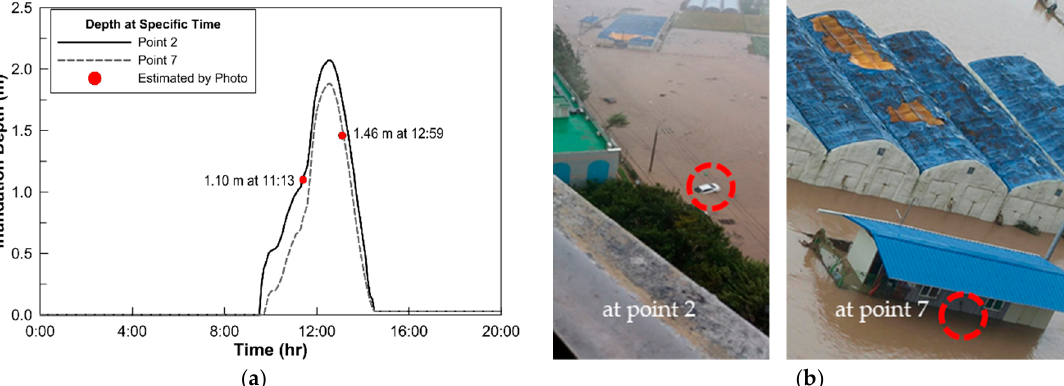
Figure 9. Maximum flood depth: ( a ) comparison of observations and simulations and ( b ) photos at the point [36].